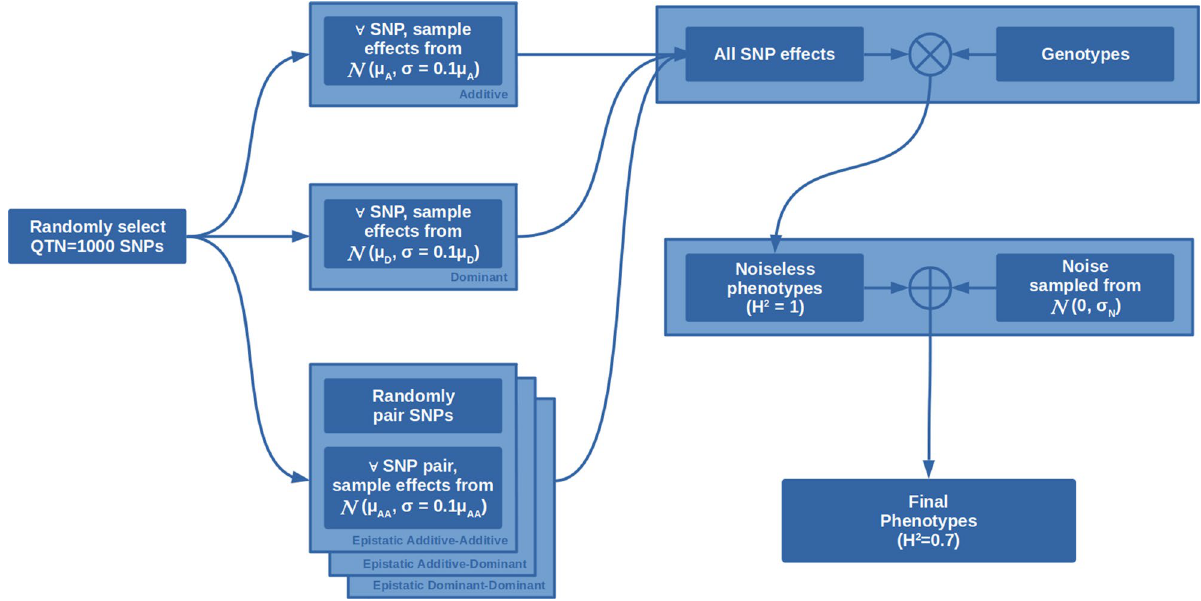
Figure 1. Procedure for simulated phenotypes generation. Effect mean values ( µ A , µ D , µ AA , µ AD , µ DD ) depend on the simulated scenario. N (µ , σ) is the normal distribution as a function of its mean and standard deviation. H 2 is the broad-sense heritability. Noise standard deviation σ N is added after SNP effects are computed so that to guarantee the desired value of H 2 = 0.7 .